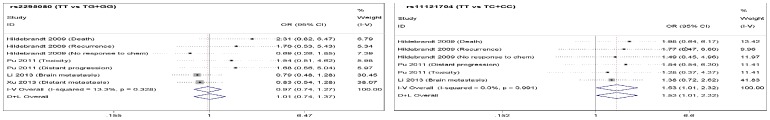
Forest plots of clinical outcomes with the mTOR rs2529080 and rs11121704 polymorphisms under the recessive model.